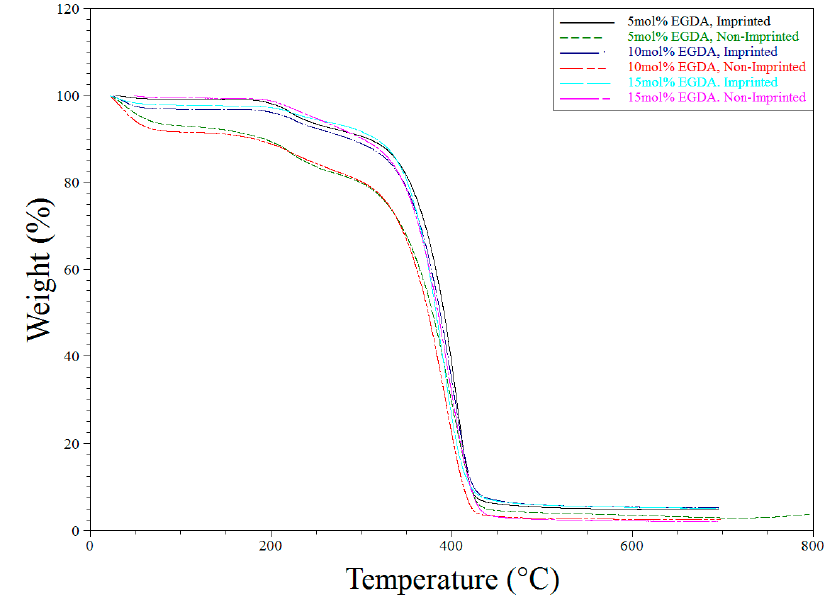
Figure 7. TGA degradation of all polymers synthesized for the variable EGDA study.